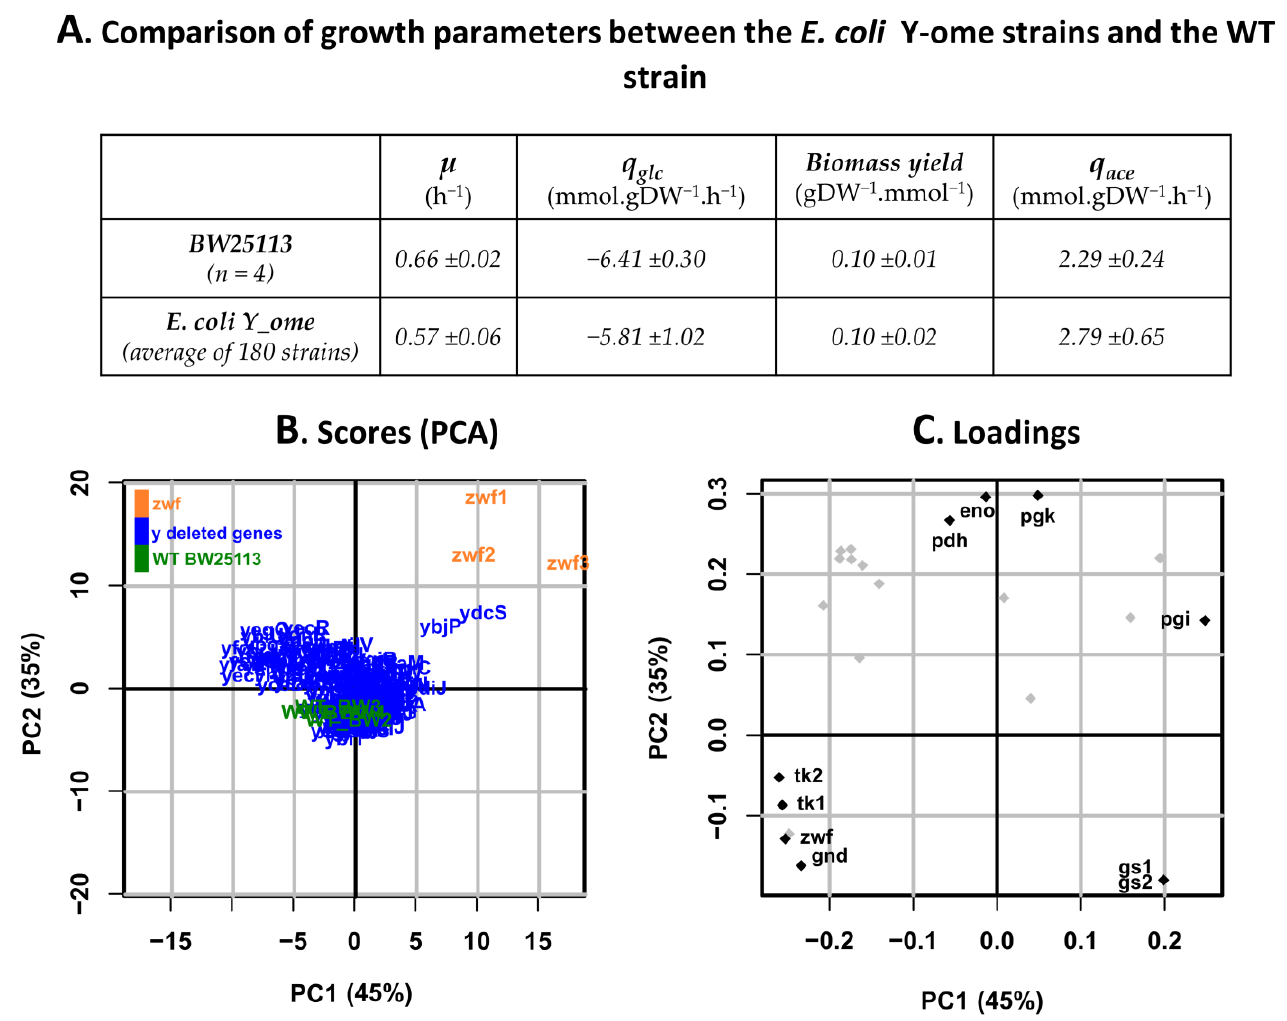
Figure 3. Comparison of the growth parameters and fluxotypes of y-ome strains with those of their parental strain. ( A ) Comparison of growth parameters between y-ome strains and the BW25113 WT strain ( µ : growth rate, q glc : glucose consumption rate, Biomass yield , q ace : acetate production rate). ( B ) PCA plots showing the strains with the most different fluxotypes across the y-ome. PC1 and PC2 represent Principal Component 1 and 2, explaining the largest variance between strains according to their flux values-the percentage of variance explained for each principal component is indicated into brackets [36], ( C ) PCA loading plot with the most impacted fluxes indicated.